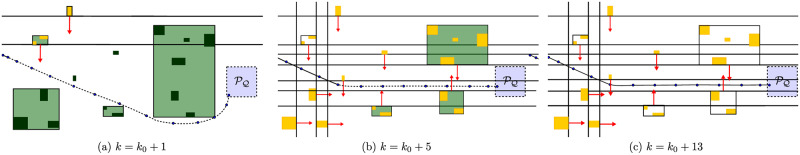
Scheme of the exterior obstacles clustering strategy.The exterior obstacles are drawn in yellow and the respective hard constraints are represented by red arrows. (a): 7 clusters are identified, 2 of which contain 3 obstacles that become exterior. (b): 3 clusters which contain the 8 remaining obstacles are identified as exterior. (c): Simulation ends with the 16 obstacles replaced by 10 hard constraints.